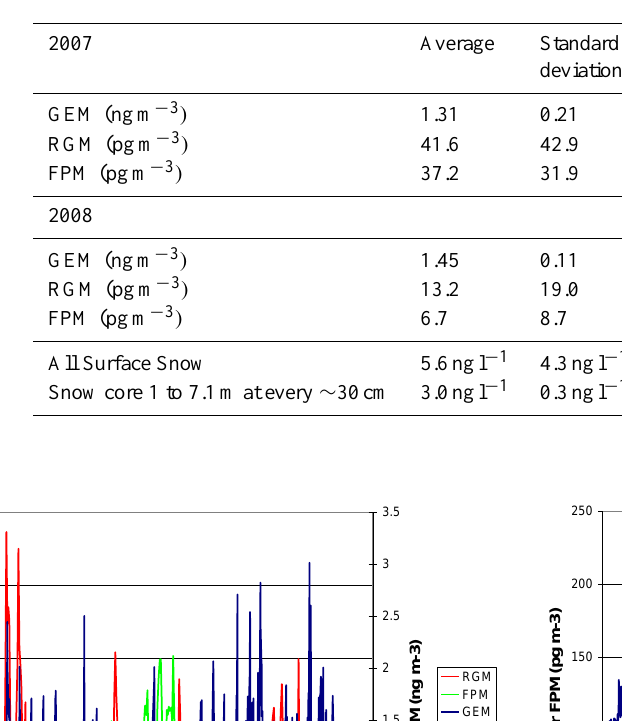
Table 1. All mercury atmospheric speciation and total mercury in snow measurements at Summit, Greenland. Dates are 13 May–15 June 2007, and 6 June–17 July 2008. Below Detection limit (B.D.L.) denotes that values were below the detection limit ( < 1.0pgm − 3 ) of the instrument. Also shown is total mercury in surface snow collected every other day and the single core to a depth of 7.1m obtained in 2008. Coefficient of variation is the standard deviation divided by the mean.